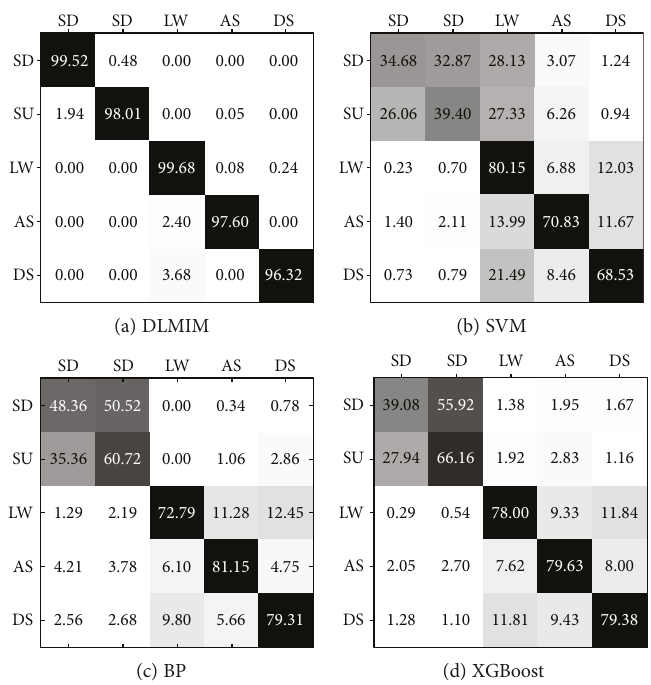
Figure 8: Confusion matrix of four locomotion mode identi fi cation